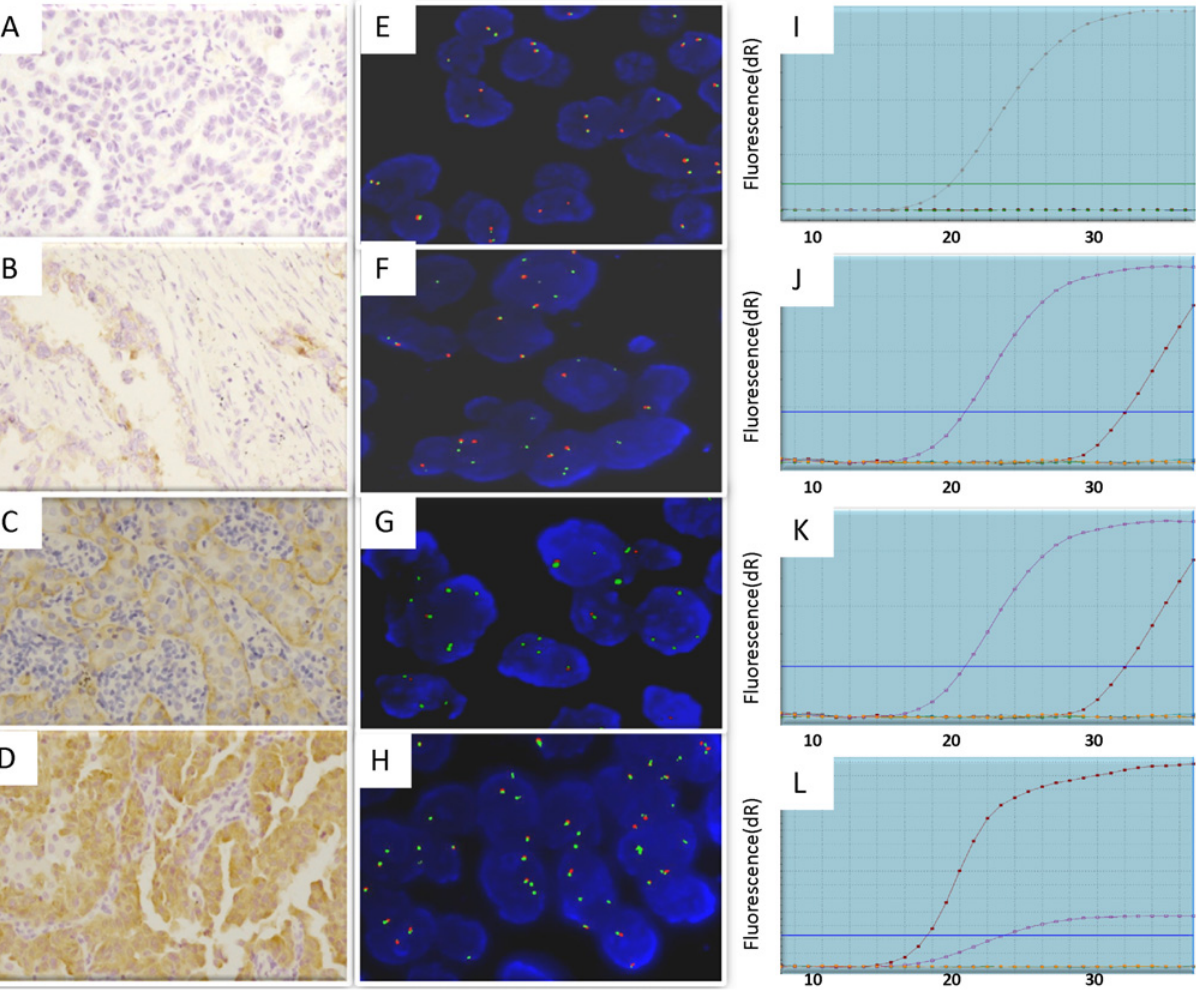
Fig 1. Detection of ROS1 fusion in lung cancer patients by IHC, FISH and qRT-PCR assays. (A – D) ROS1 IHC staining using D4D6 antibody. (A) Score 0/negative showing no staining; (B) Score 1+ showing faint cytoplasmic reactivity; (C) Score 2+ showing moderate cytoplasmic staining; and (D) Score 3+ showing intense granular cytoplasmic staining in (cid:1) 10% of tumor cells. Original magnification ×200. (E – H) FISH analysis using ROS1 dual color break-Apart FISH probes to detect ROS1 fusion as split red and green signals. (E) FISH-negative case showing intact two fused signals per nucleus. (F-G) FISH-positive cases representing split (red and green) signals. (H) FISH-positive case showing isolated green signals. Original magnification ×1000. (I – L) Graphs from qRT-PCR showing change in the normalized reporter signal (delta Rn) against PCR cycle number using AmoyDx ROS1 fusion gene detection kit.